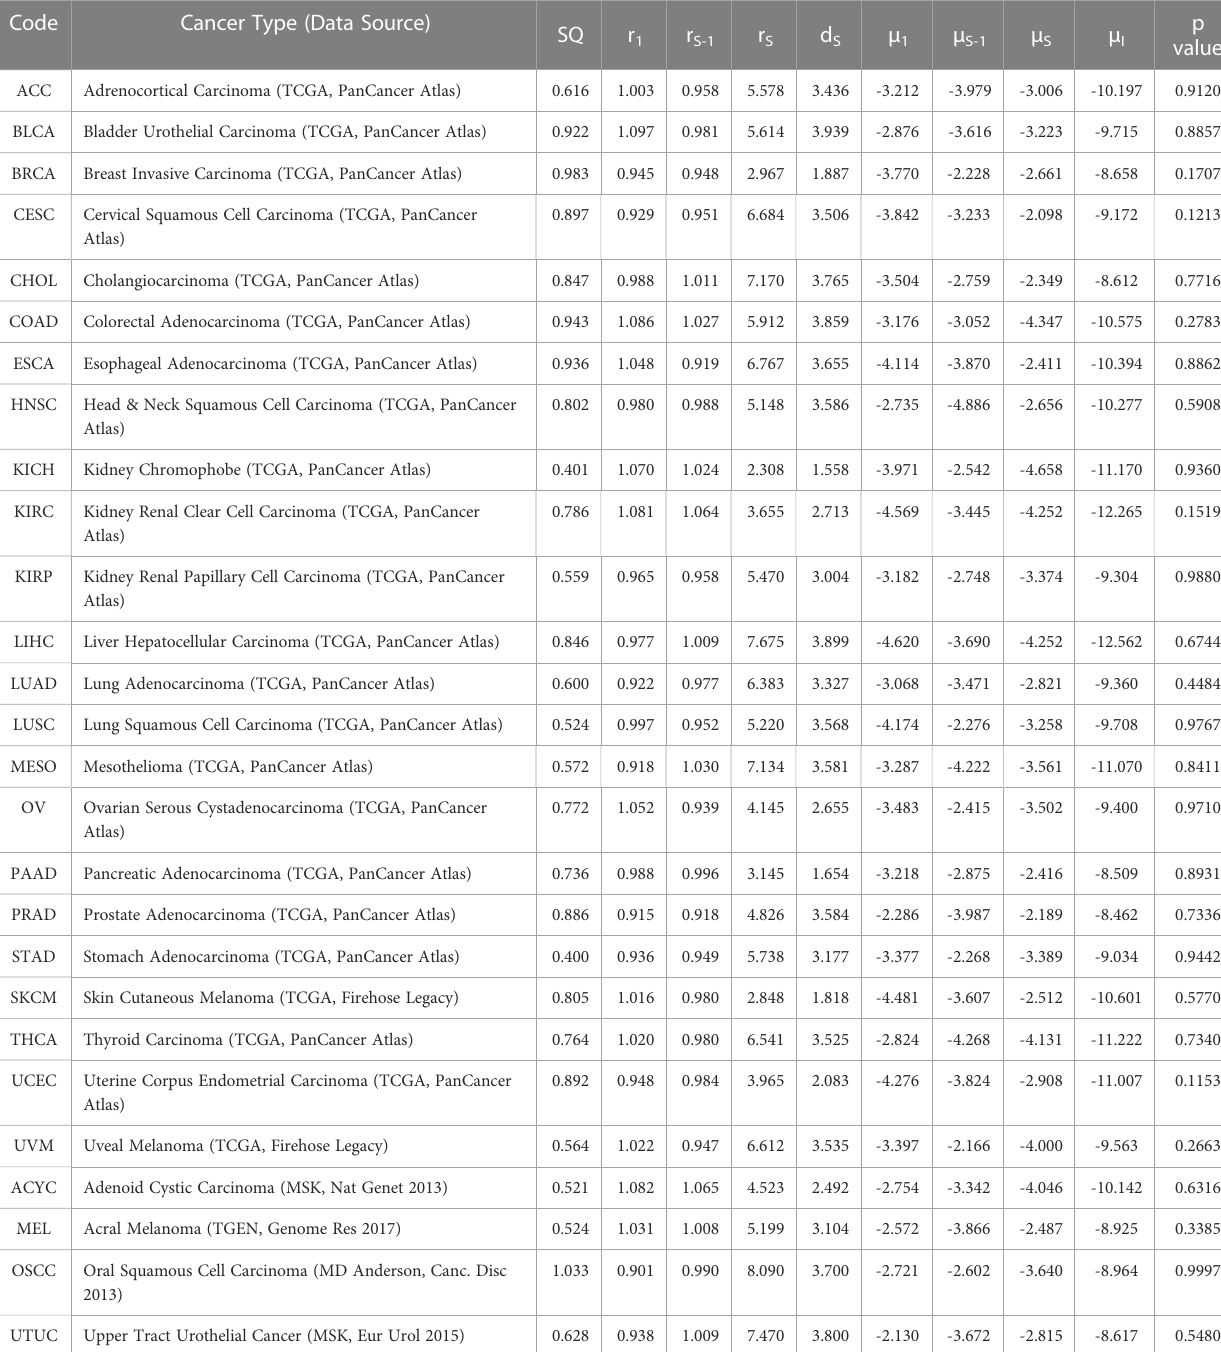
TABLE 1 Tumor-speci fi c carcinogenic pro fi les and p values of survival curves ( µ values are in log 10 while SQ are log-SSR values).